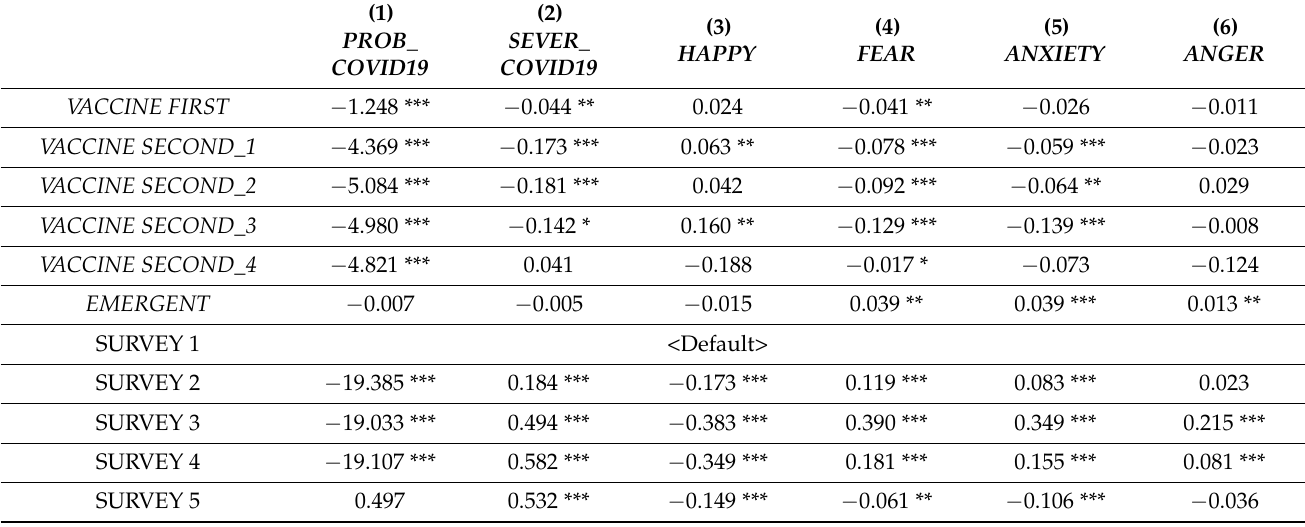
Table 3. FE model. Dependent variables are perceptions of COVID-19 and mental health. Sample including males and